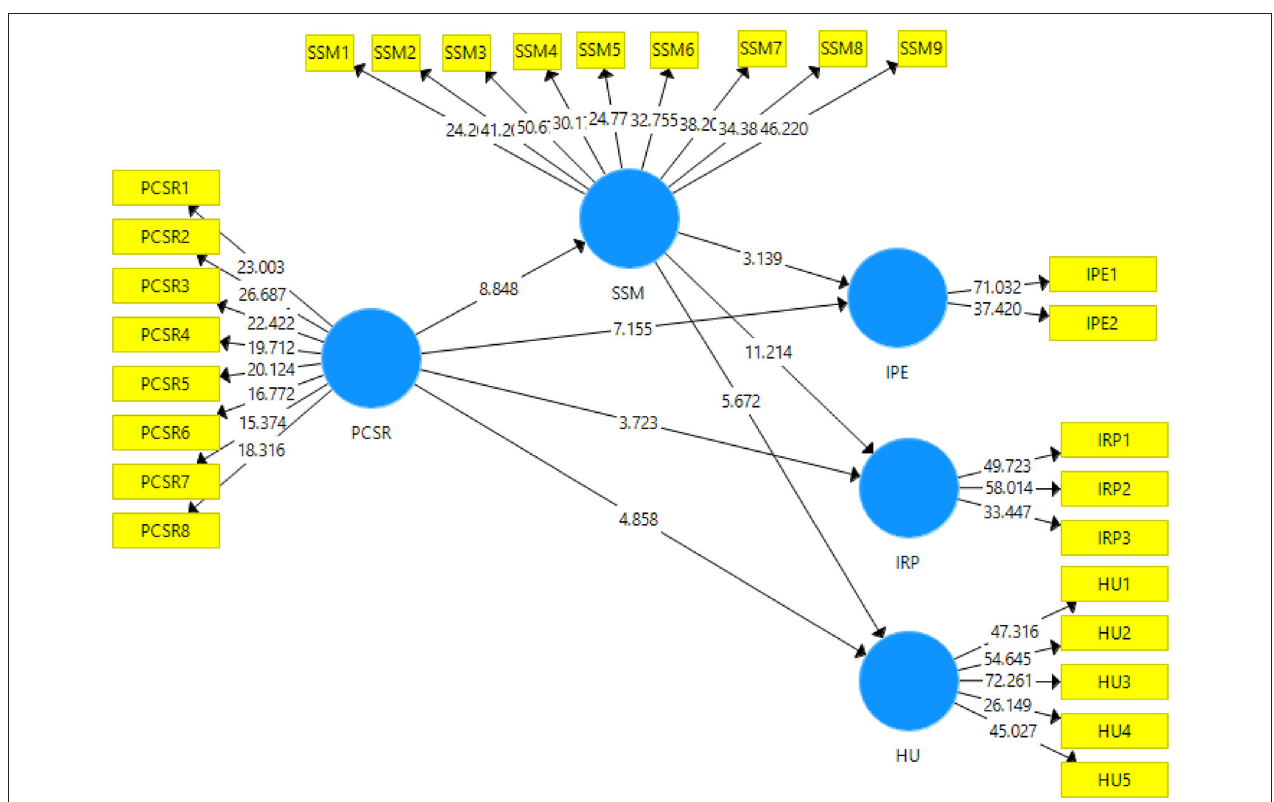
FIGURE 3 | Output of structural model bootstrapping.